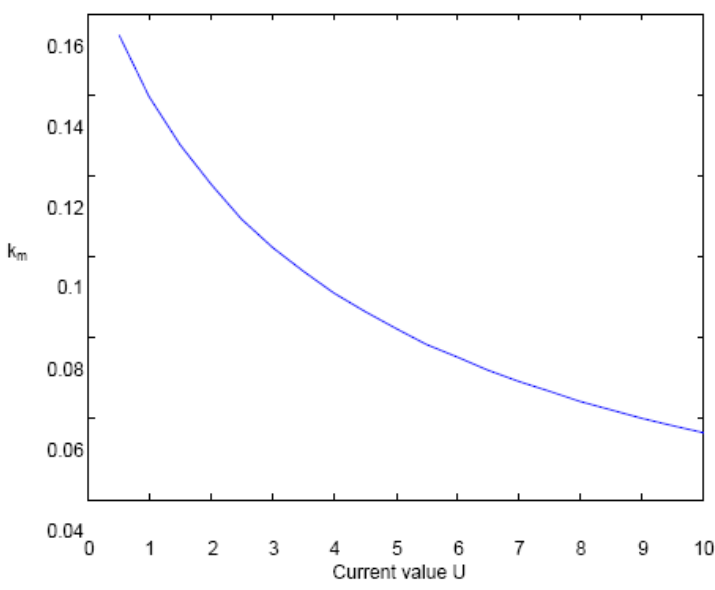
Figure 5. Plot of Equation (13) depicting the decreasing behaviour of the maximum k with respect to the surface current U ˆ allowable value m